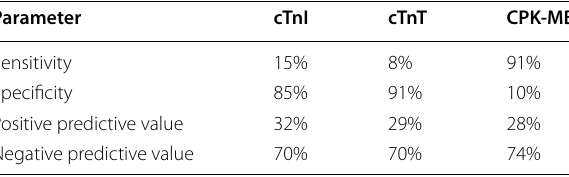
Table 6 The accuracy of the current cut‑off values of cTnI, cTnT and CPK‑MB as markers of subclinical myocarditis for prediction of CAI in